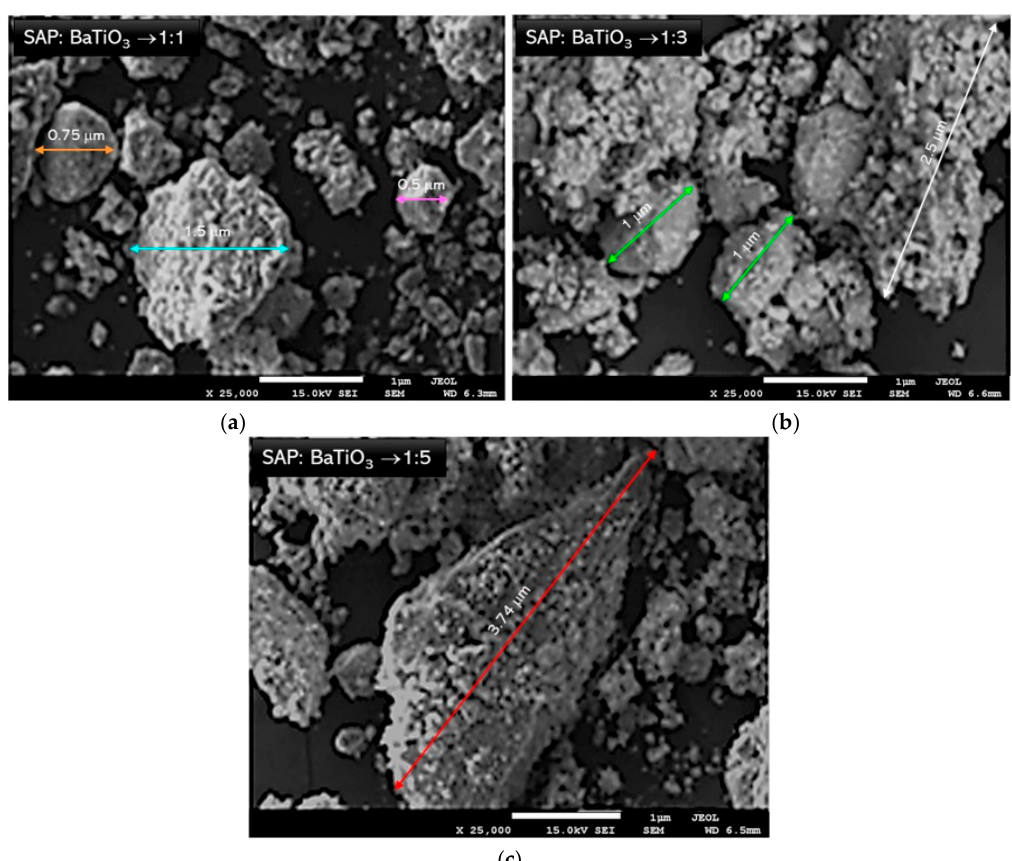
Figure 8. SEM images of SAP suspensions of barium titanates with different mass ratio of SAP and BaTiO 3 , i.e., 1:1 ( a ); 1:3 ( b ) and 1:5 ( c ).